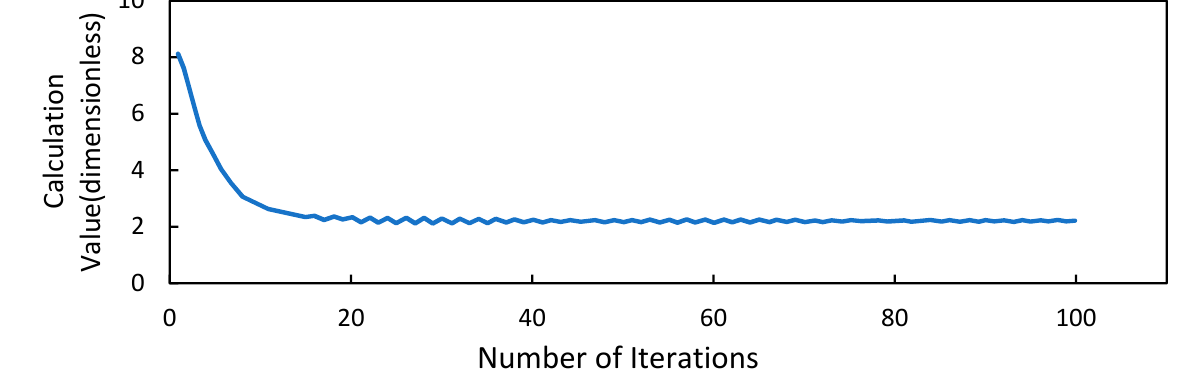
Figure 20. The process of optimization of fuzzy neural network PID control.